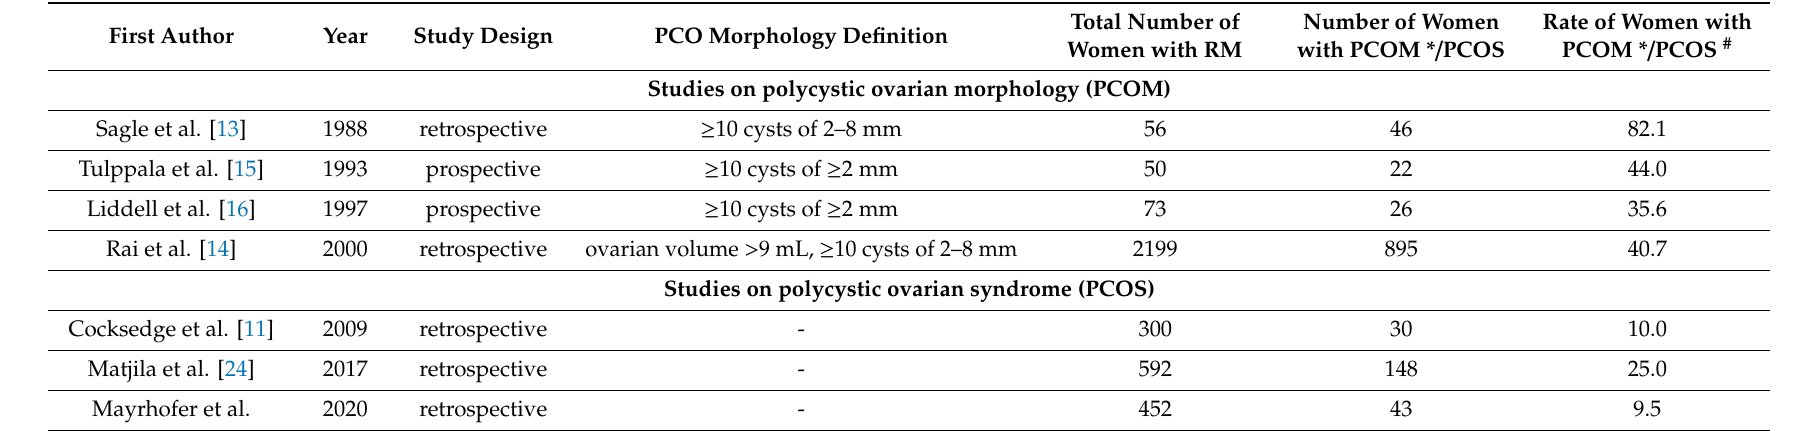
Table 2. Characteristics and results of the studies on the prevalence of polycystic ovarian morphology and PCOS in RM included in the